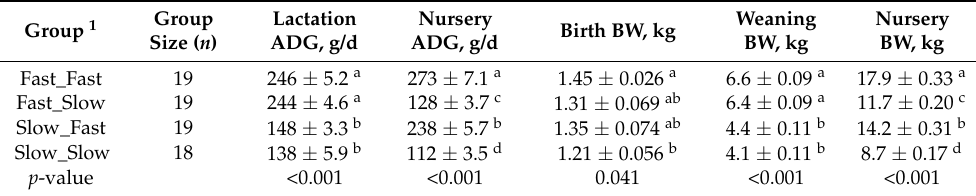
<0.001 <0.001 0.041 <0.001 <0.001 1 Fast_Fast: pigs showing fast growth during the lactation and nursery periods, Fast_Slow: pigs showing fast growth during the lactation period and slow growth during the nursery period, Slow_Fast: pigs showing slow growth during the lactation period and fast growth during the nursery period, and Slow_Slow: pigs showing slow growth during the lactation and nursery periods. a,b,c,d Values with different letters in the same column are significantly different, according to ANOVA and Tukey’s adjust. Sows and their litters were housed in individual farrowing pens (2.6 × 1.8 m 2 )